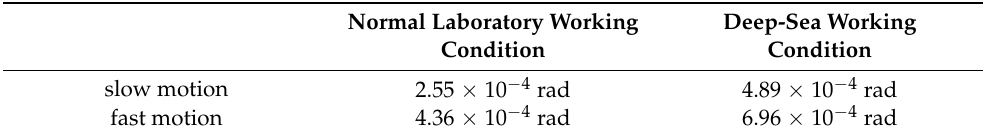
Table 5. The maximum steady-state tracking error of the PP-NFTSMC-ESO controllers under different working